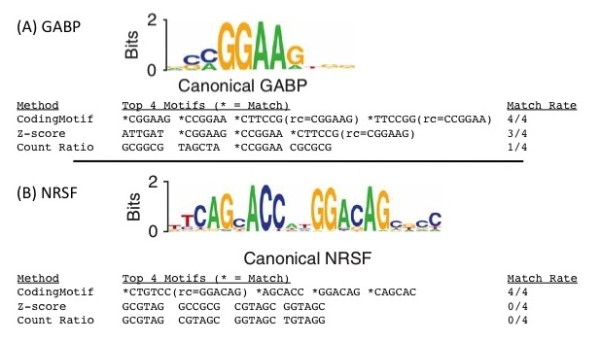
Comparison of CodingMotif and parametric methods for known binding motifs. A) All 4 of the top 4 motifs predicted by CodingMotif p-value are exact matches to the canonical motif for the human transcription factor GABP. For comparison, 3 of the top 4 motifs ranked by z-score, and 1 of the top 4 motifs ranked by the ratio of counts in the real sequence to the average in the null distribution, match the GABP canonical motif. B) All 4 of the top 4 motifs predicted by CodingMotif p-value match the canonical motif for NRSF. For motifs ranked by z-score 0/4 of the top motifs match the canonically known motif. 0/4 of the top motifs ranked by count-ratio match the canonically known motif.